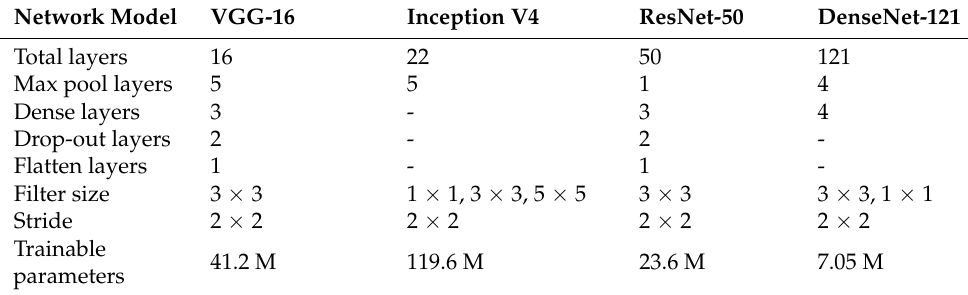
Table 4. Pre-trained network architecture